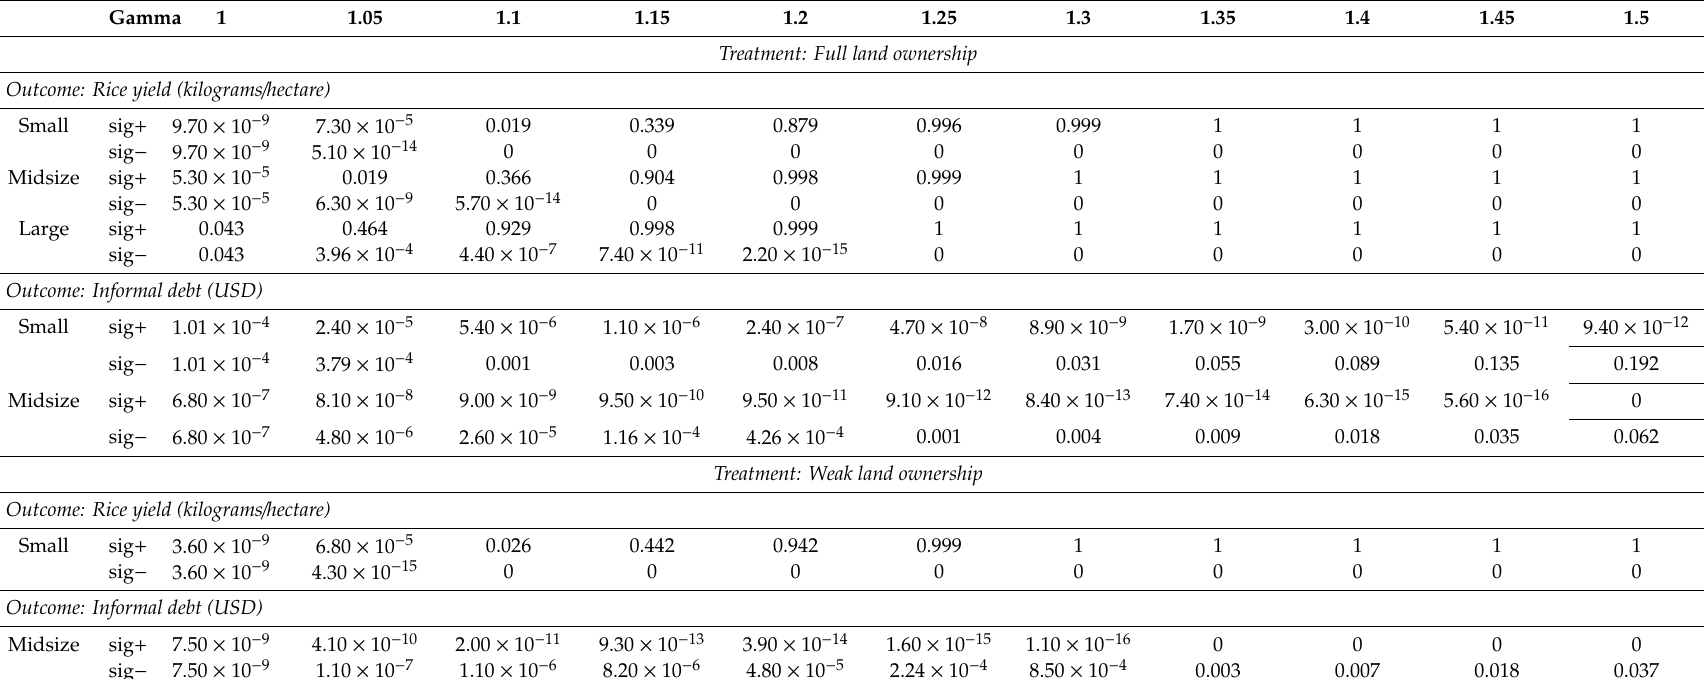
Table 7. Sensitivity analysis with Rosenbaum bounds for treatment